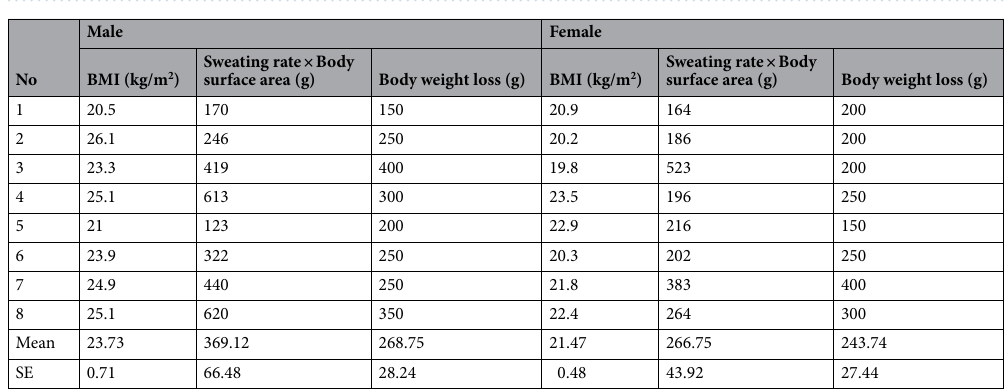
Table 2. The body mass index (BMI, kg/m 2 ), total water loss, and body weight loss in all participants with 30 min physical exercise (male n = 8; female n = 8). The body mass index was calculated by body weight (kg) / body height 2 (m).